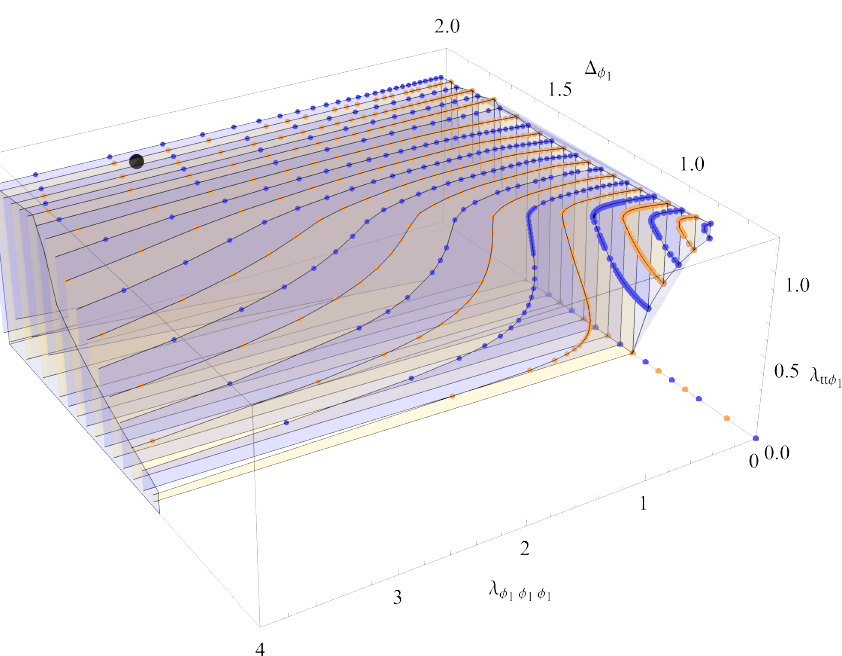
Figure 10. Bounds on the OPE coefficients λ the O(3) -breaking magnetic line defect. The black dot is the prediction from the ε -expansion. The gaps are given in eq. (4.10). Λ = 21 , P = 41